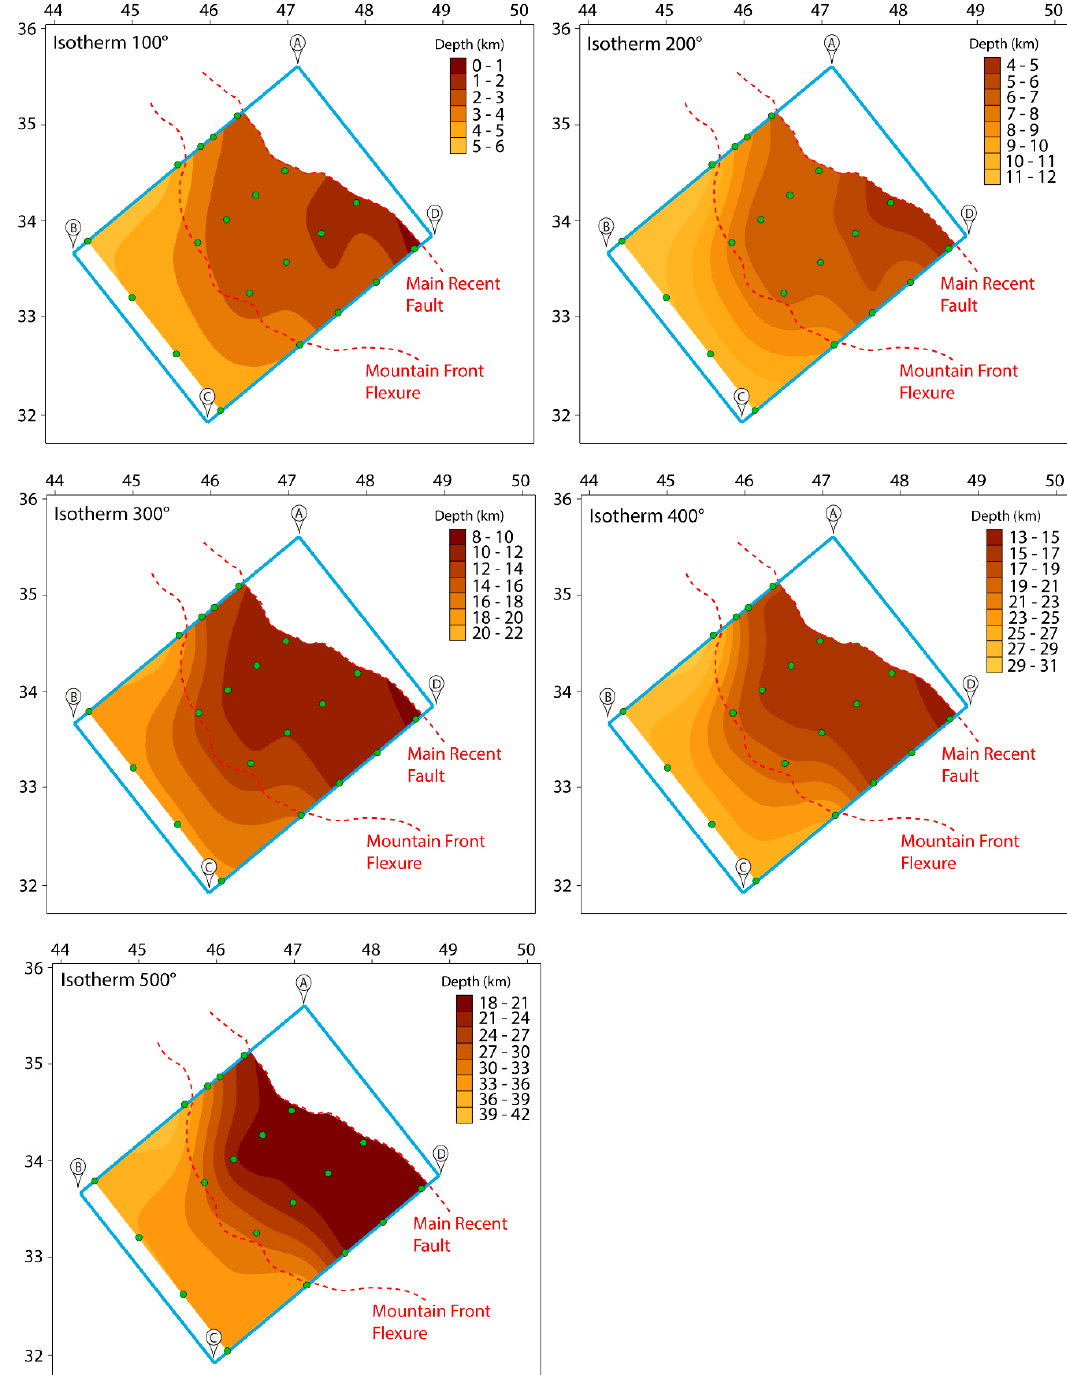
Figure 9. Isotherm depth contour maps obtained by spline interpolation for the 100–500 °C temperature range (green dots are pseudo-wells used for geotherm calculation).